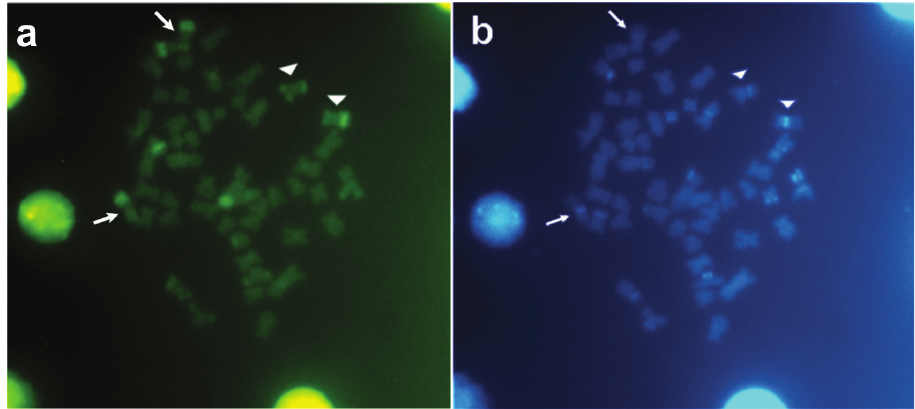
and ( b ) DAPI. Arrows 3